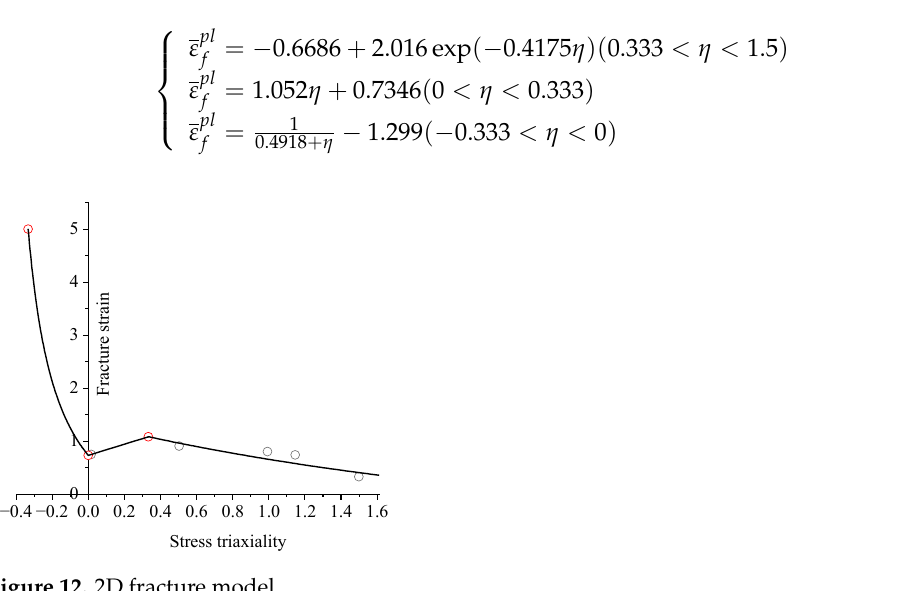
Table 2. Average stress triaxiality, Lode parameter, and fracture strain of each specimen.